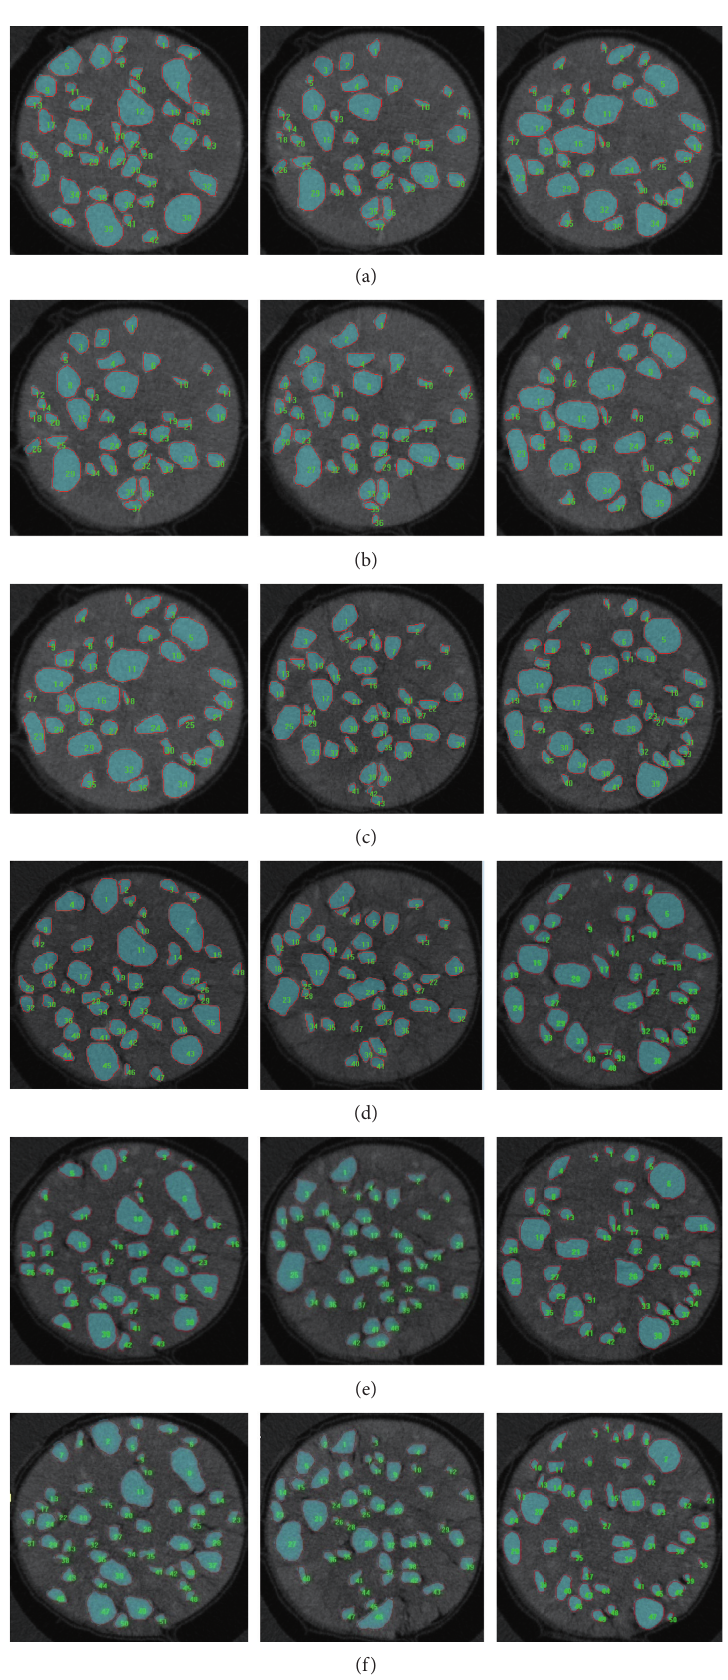
Figure 7: Edge detection of rock blocks in CT images (the edge detection result was plotted on the original CT images). (a) ε � 0%. (b) ε � 1.756%. (c) ε � 3.106%. (d) ε � 4.427%. (e) ε � 6.649%. (f) ε �